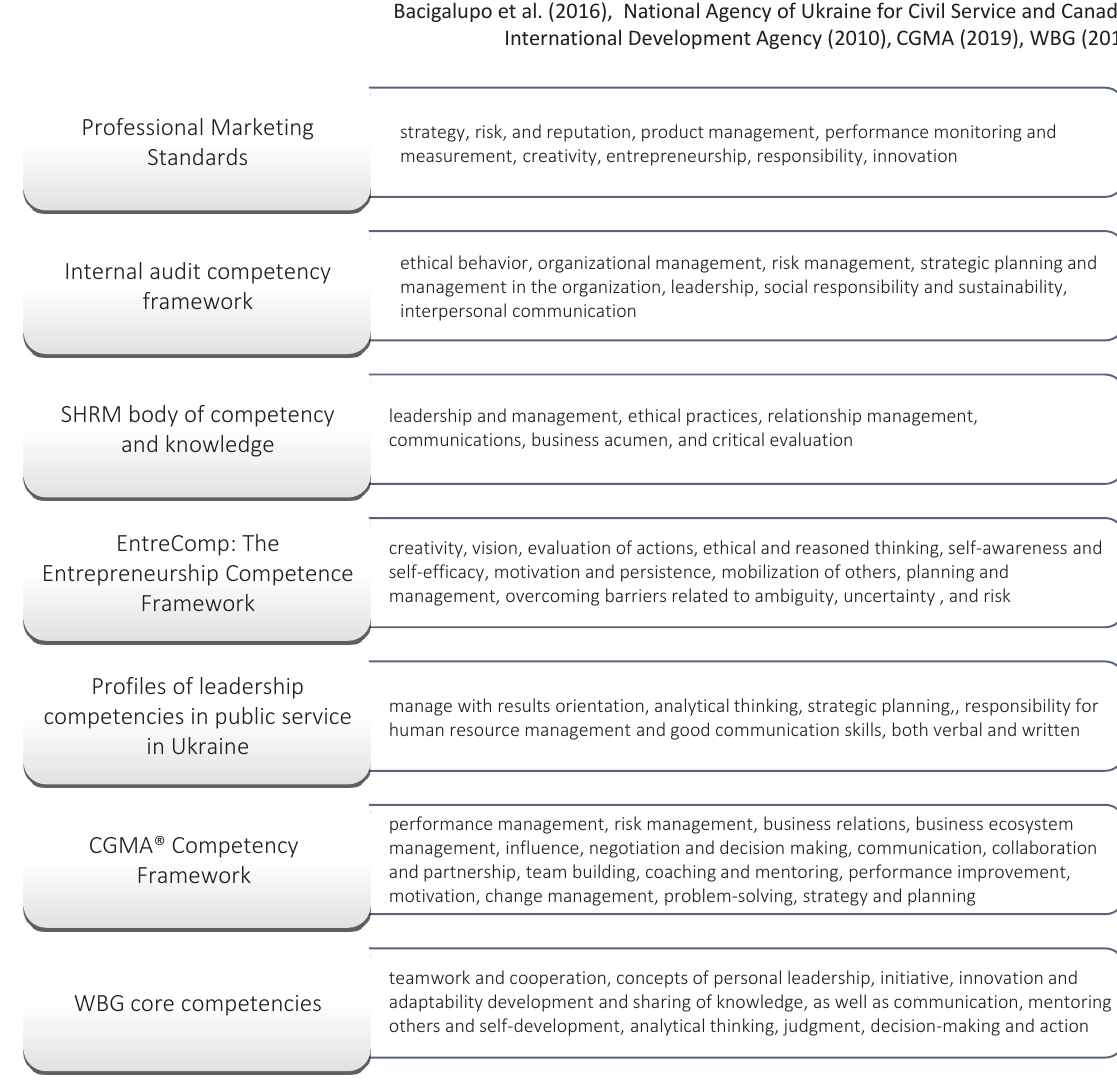
Figure 2. Management competencies in international professional